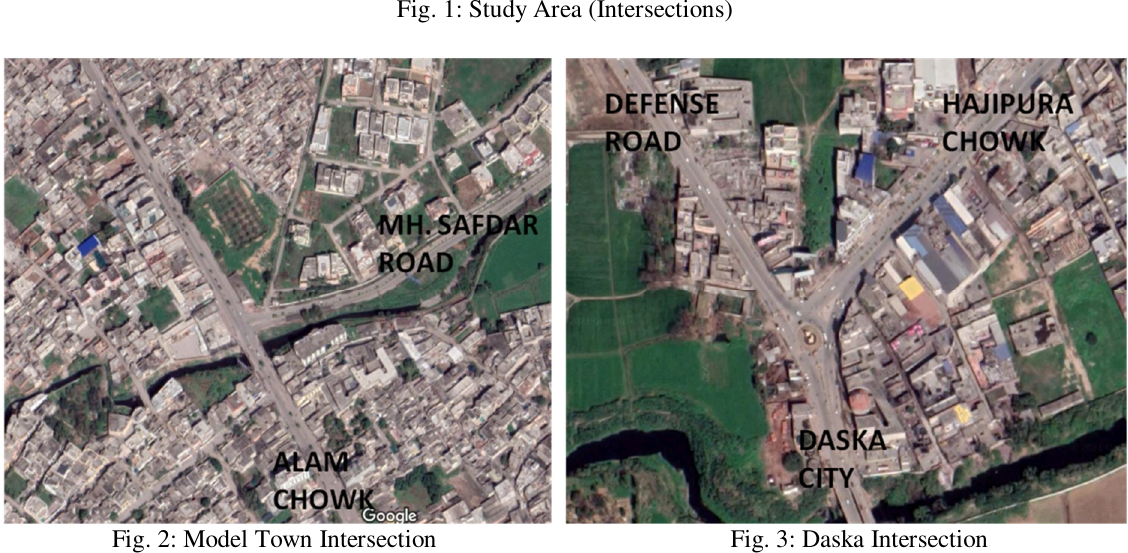
Fig. 2: Model Town Intersection Fig. 3: Daska